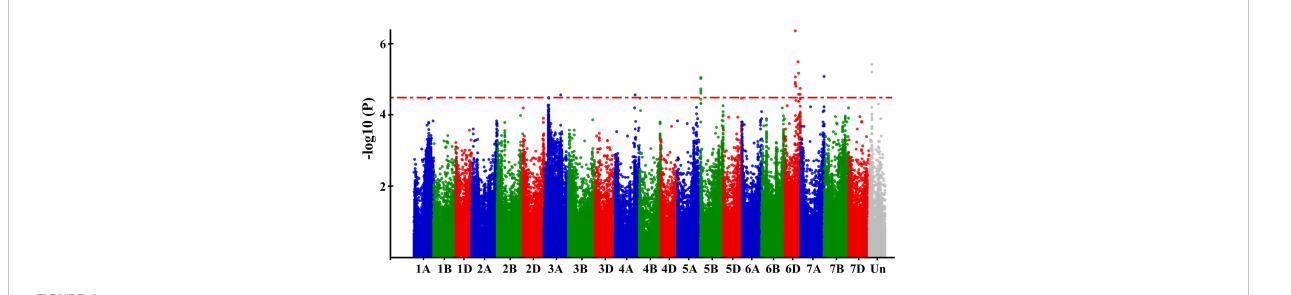
FIGURE 4 Manhattan plots of the GWAS results for GZnC. The resulting BLUPs of GZnC of 382 wheat accessions across three environments was used for GWAS. -log10 ( P -value) of each SNP was shown in the Manhattan plot.